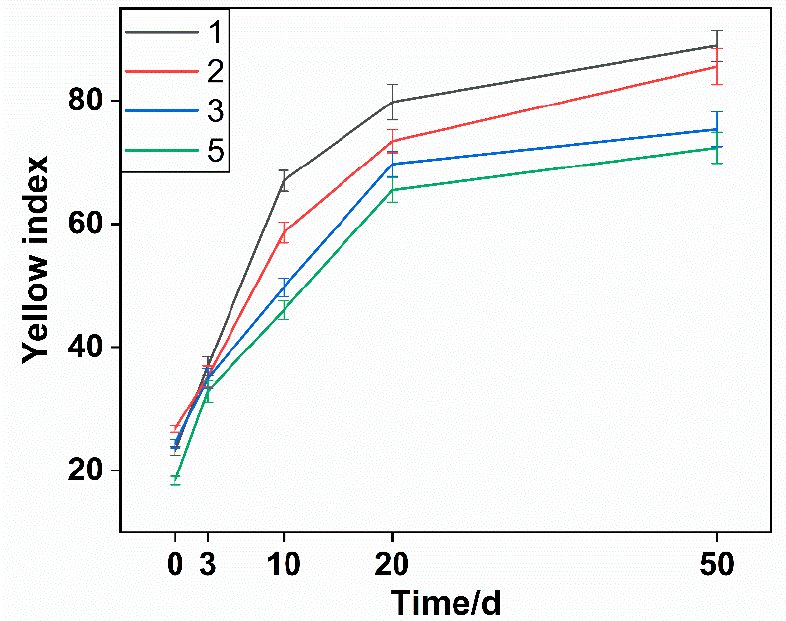
Figure 7. The influence of different antioxidants on the yellow index of the PA56T samples.